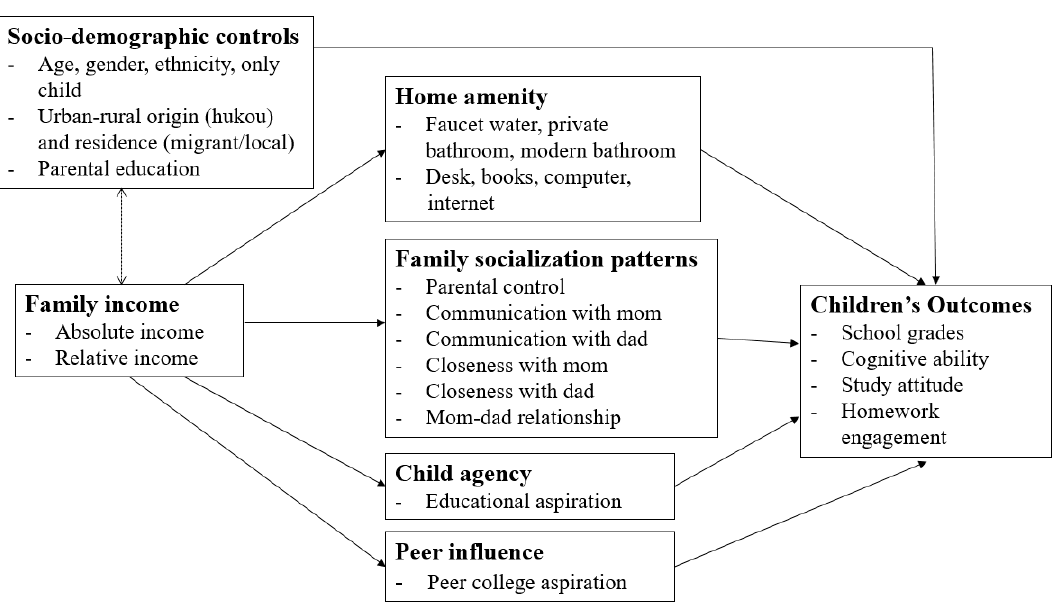
Figure 1. Conceptual Model.